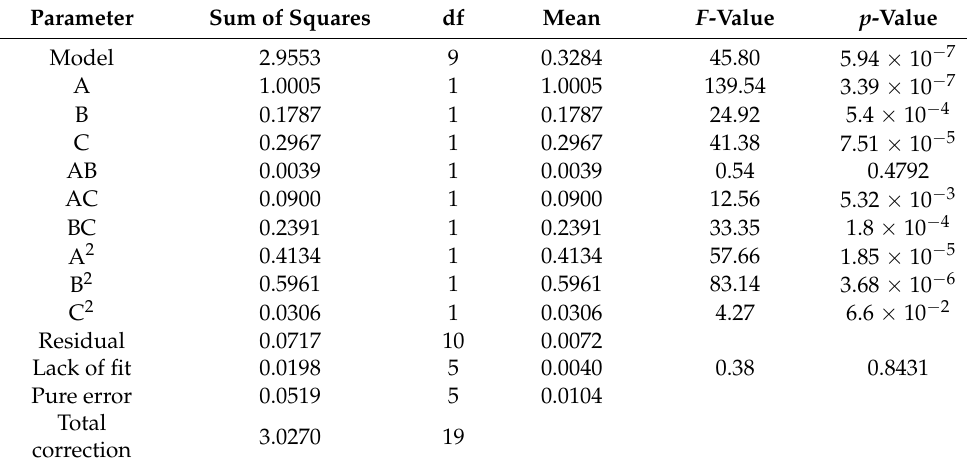
Table 4. ANOVA for a second-order polynomial model. Parameter